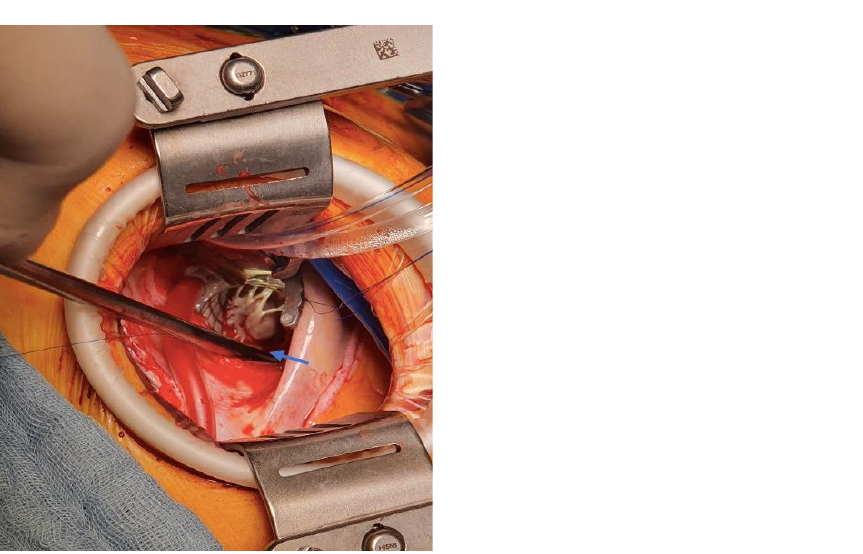
Figure 2. Cardiac magnetic resonance image of the tumour in the left ventricle and papillary muscle at the base of the anterolateral papillary muscle (white arrow, left ventricle tumour); RV, right ventricle; LV, left ventricle.